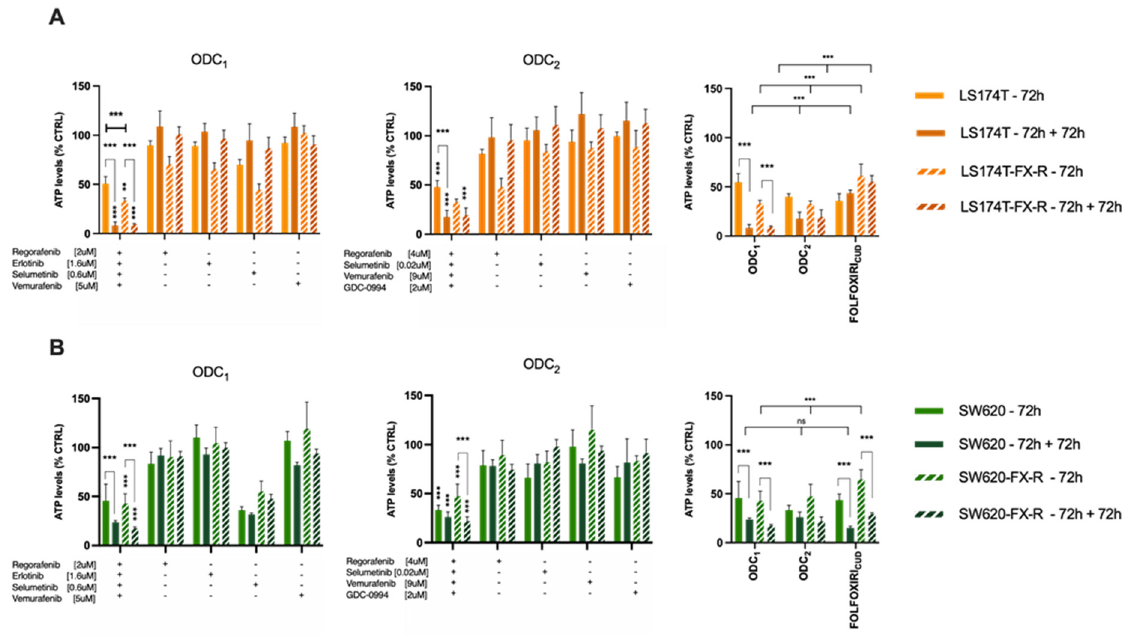
Figure 6. Activity of the ODCs in FX-naïve and FX-resistant cells in 2D culture of LS174T ( A ) or SW620 ( B ) cells (N = 3, n = 3). Error bars represent the SD and significances of *** p < 0.001 (two-way ANOVA with post hoc Tukey’s and Sidak’s multiple comparisons test).